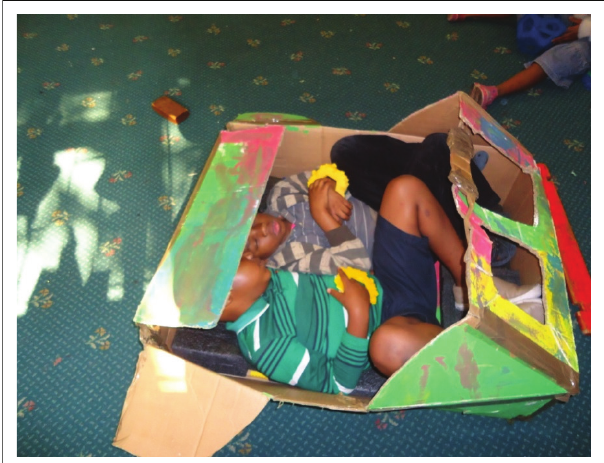
FIGURE 2: The understanding after the conflict had been